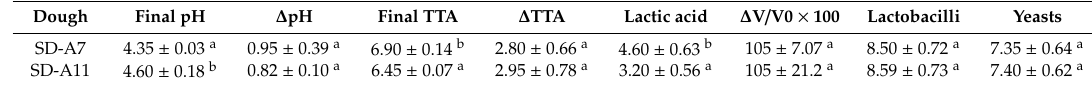
Table 3. Values (mean ± standard deviation) of pH, Total Titratable Acidity (TTA; mL NaOH), lactic acid (g/kg), volume increase (%), and microorganism (lactobacilli and baker’s yeast) concentrations (log (CFU/g)) after sourdough fermentations carried out by L. brevis A7 (SD-A7) and L. farciminis A11 (SD-A11).